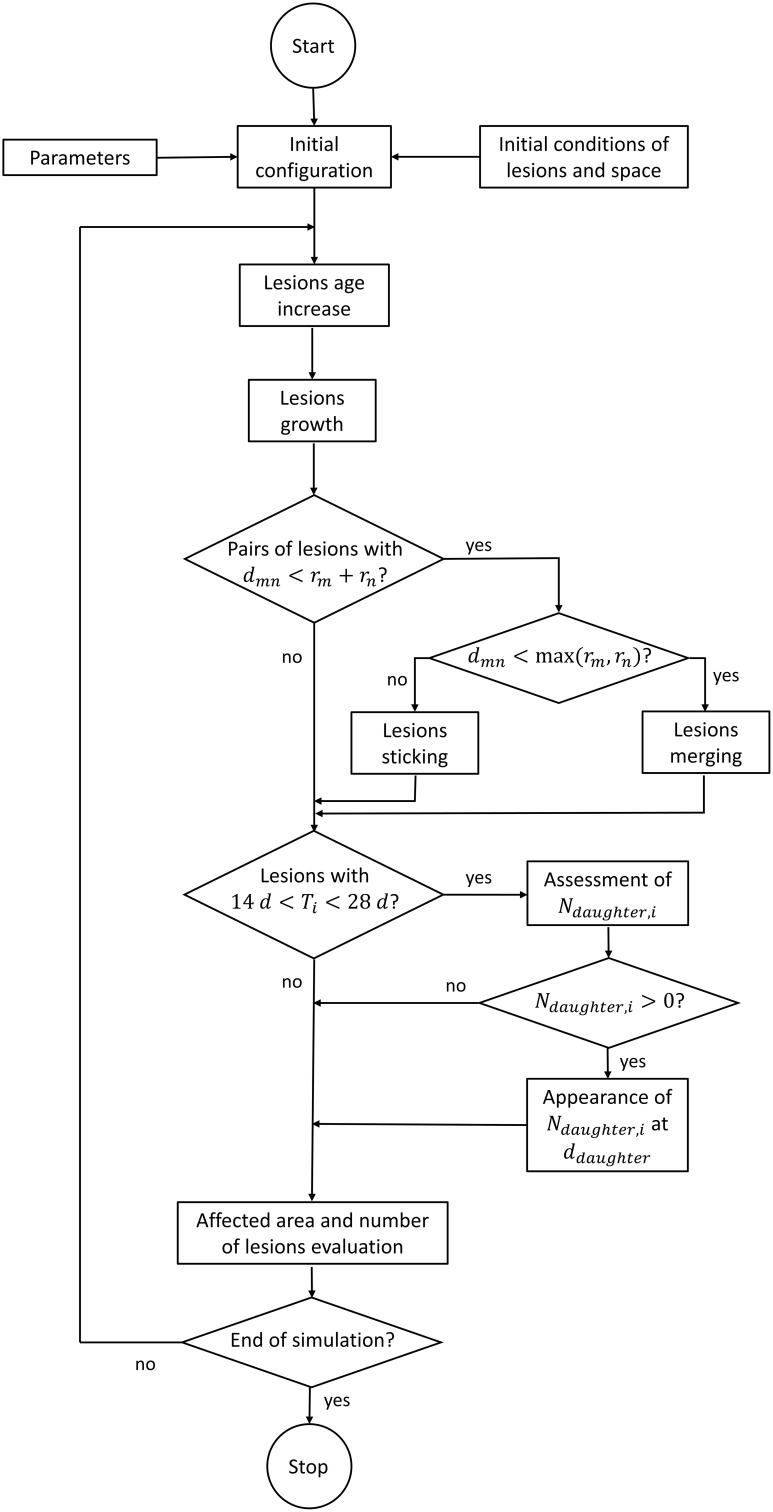
Flow chart of the computer code.